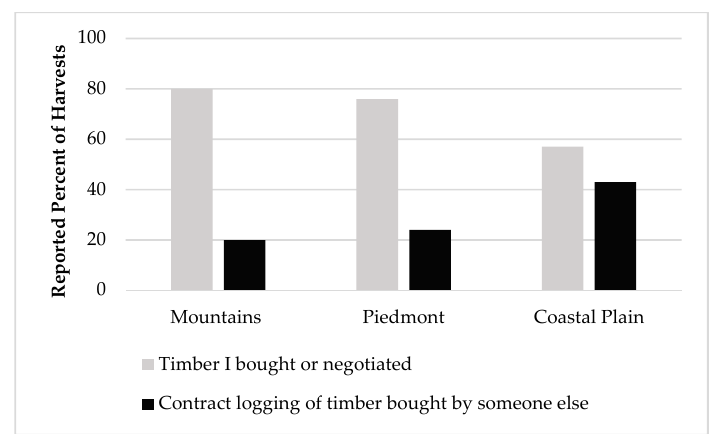
Figure 4. Reported source of timber harvested in past year.